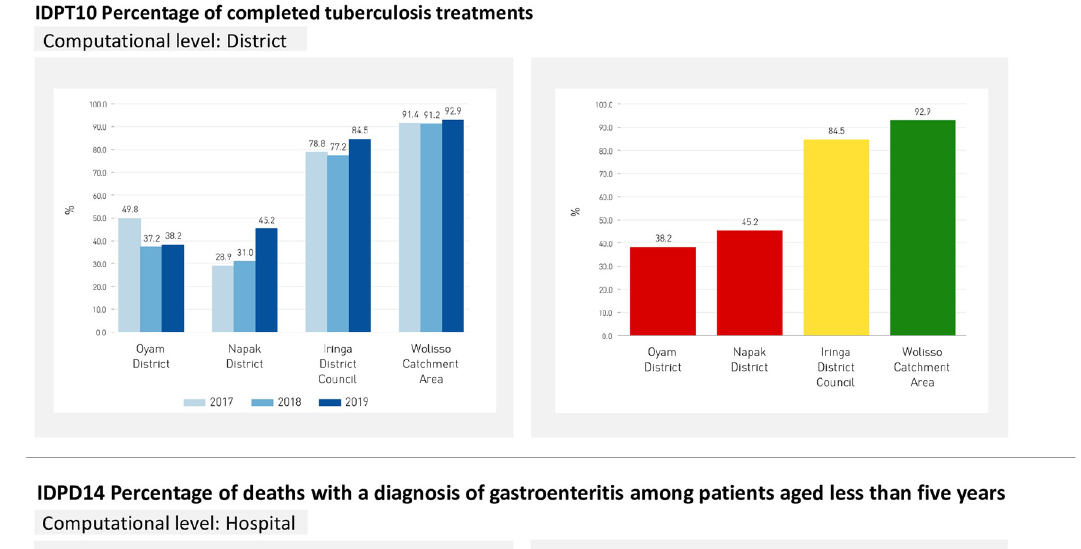
PLOS ONE | https://doi.org/10.1371/journal.pone.0266225 March 31,